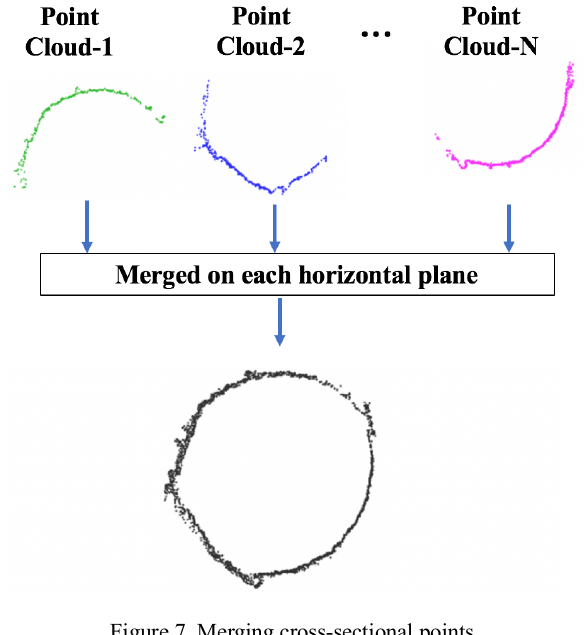
Figure 7. Merging cross-sectional points